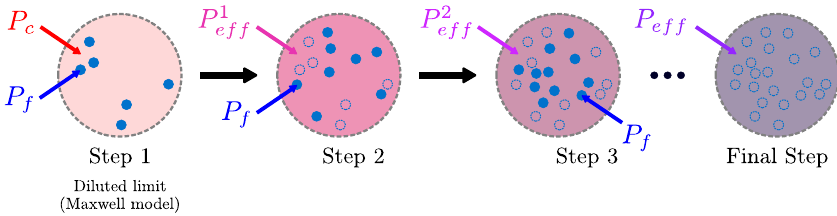
Figure 6. Schematic representation of the Bruggeman’s theory.